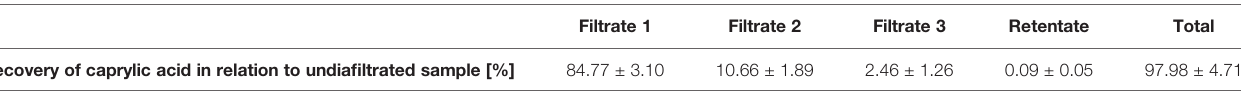
TABLE 2 | Removal of caprylic acid during dia fi ltration step with indicated recoveries in the fi ltrates following every cycle and the fi nal preparation (retentate) in relation tostarting, undia fi ltrated